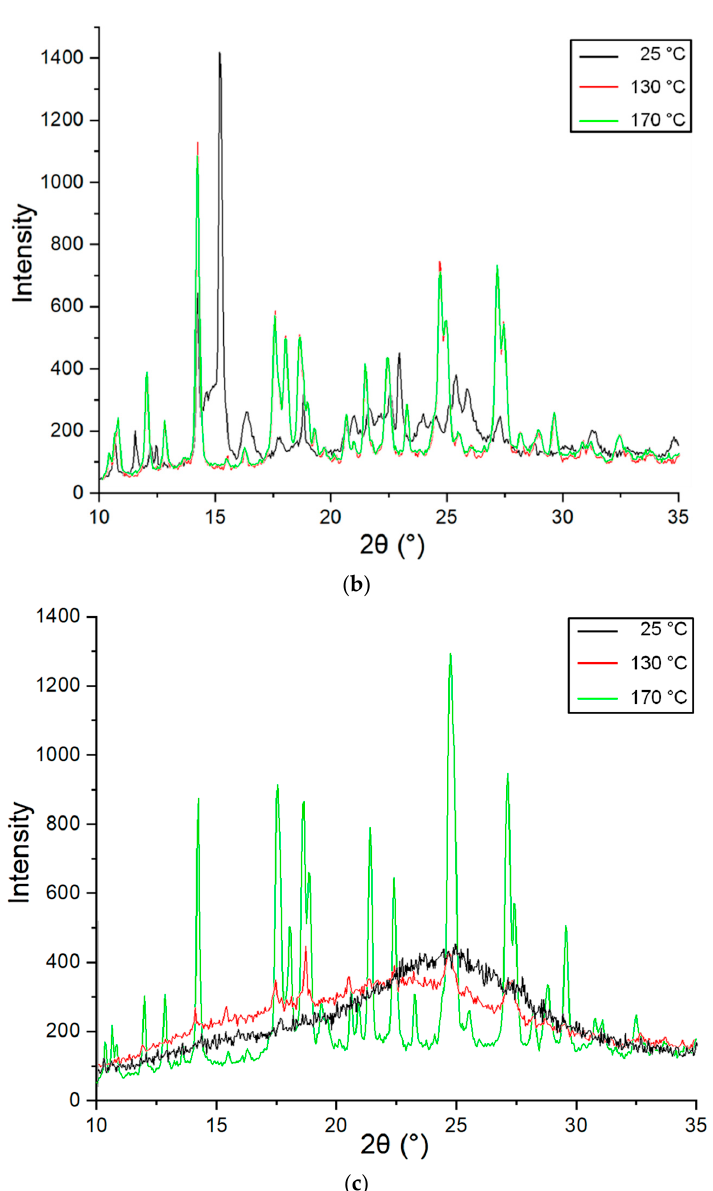
Figure 6. In situ variable-temperature XRPD patterns for different taxifolin forms: ( a ) raw taxifolin; ( b ) taxifolin microtubes; ( c ) taxifolin microspheres. ( b ) taxifolin microtubes; ( c ) taxifolin